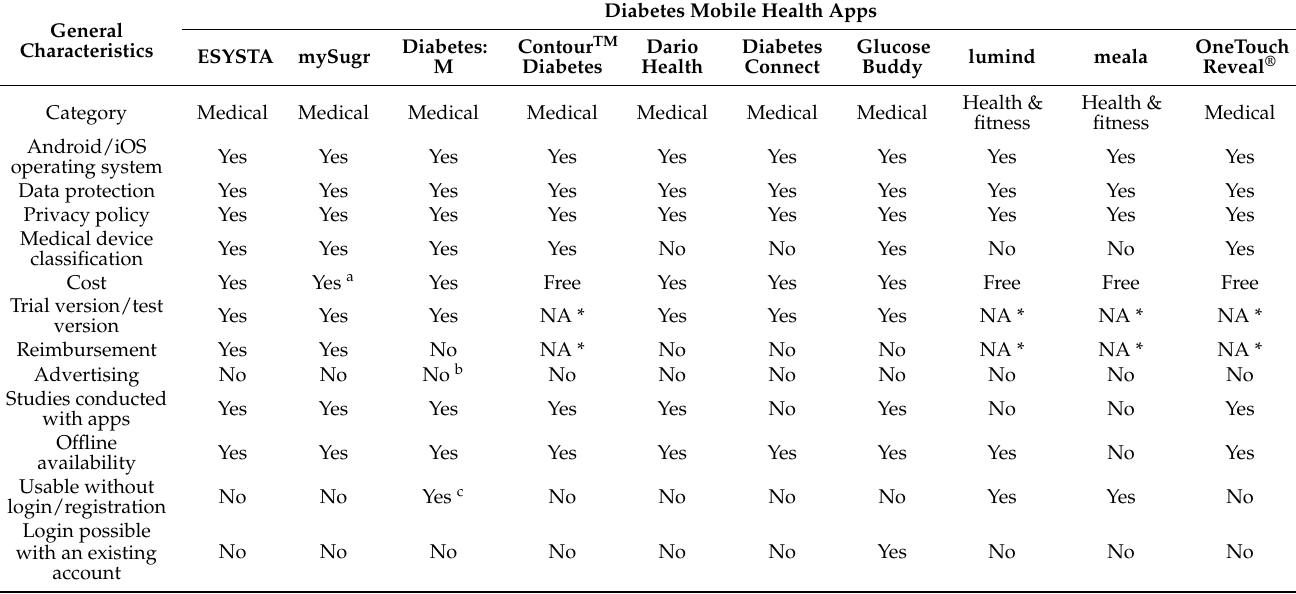
Table 3. General characteristic criteria of mobile health apps for diabetes patients.